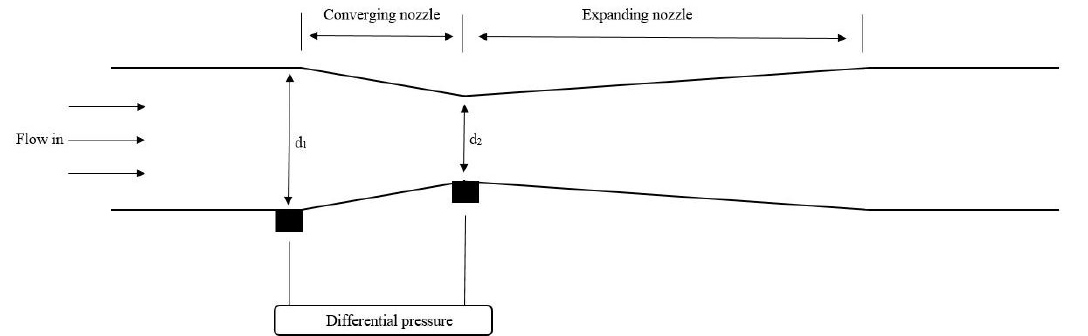
Figure 7. Principle of a venturi meter. The DP transmitters are located before the pipe is converging ( d 1 ) and when the pipe is most converged ( d 2